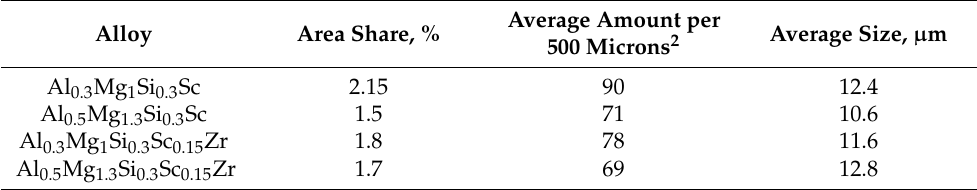
Table 3. Size and amount of intermetallic compounds in the investigated alloys.